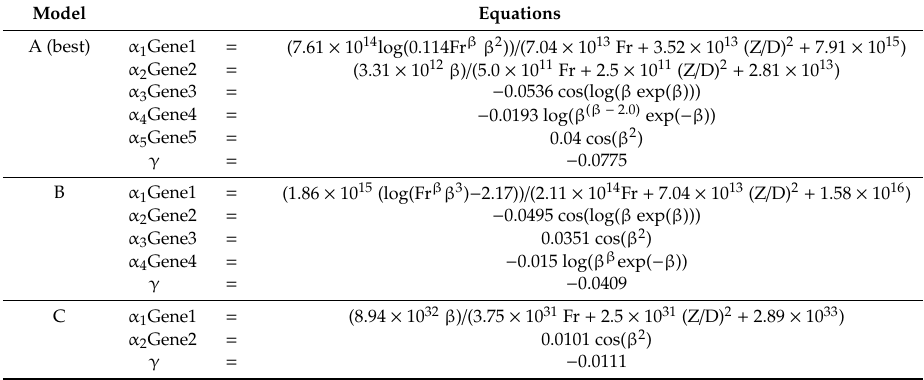
Table 1. The mathematical expressions for the Pareto-optimal MGGP